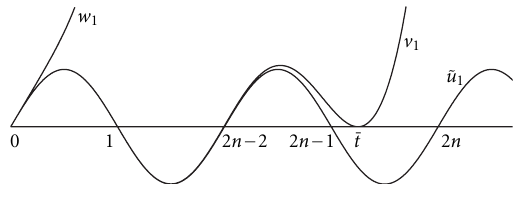
Figure 3.1. Proof of Lemma 3.3 for n =